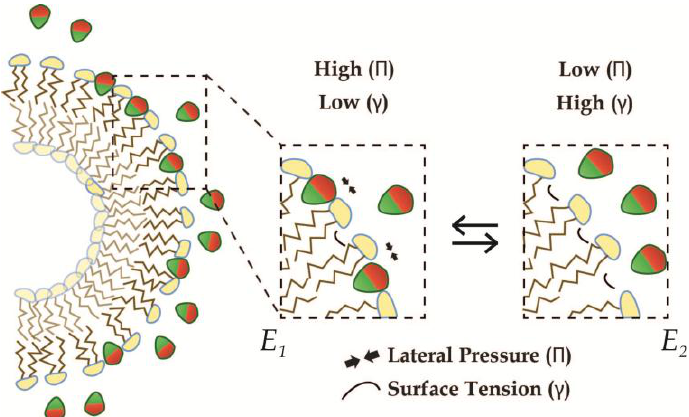
Figure 7. Thermodynamic model of the insertion of AIMs into liposome membranes. Half a liposome is shown here with an excess of amphiphiles ( red / green ). Inset shows the insertion of amphiphiles, where the properties of the membranes permit. In energy-state E 2 ( right ) the outer leaflet is stretched and thereby penalized with an increase in surface tension, while the lateral pressure remains low. Upon amphiphile insertion, the lateral pressure increases, while the surface tension is reduced until further insertion is not energetically favorable ( left ).